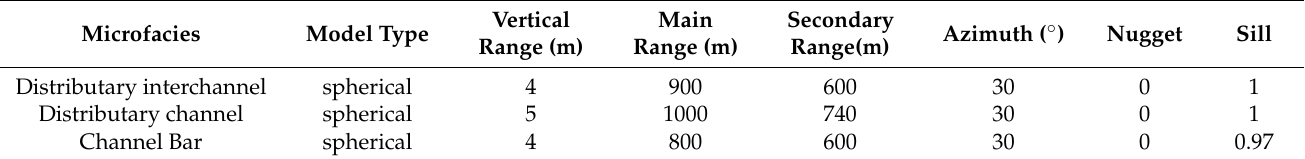
Table 2. Variation function analysis results in Ct3 study area in P 2 h 8